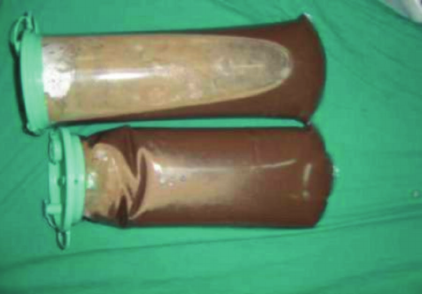
Figure 4: The 7 liters of removed purulent